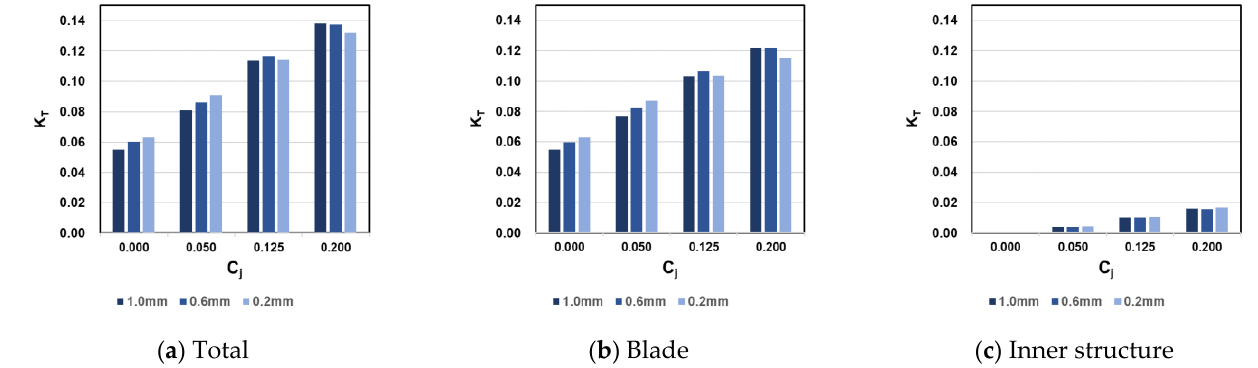
Figure 14. K T according to C j for each part of the propeller with each slit height ( J A = 0.4). When the jet is not injected, the highest thrust is displayed at h S = 0.2 mm, which is a phenomenon manifested by the hydrofoil shape. Looking at Figure 12, there is a part where the hydrofoil is cut by the slit in the with jet section. The lower the slit height, the more the existing hydrofoil shape will be maintained, so most will appear when the jet is not injected in the lowest slit height. However, although the thrust increase appears differently depending on the slit height, most thrust appears when C j = 0.2 and h S = 1.0 mm. Figure 15 shows the thrust PUA and velocity distribution of the propeller surface by C j . Only the negative tangential velocity contour is shown for convenience to see the jet distribution. The jet injection distribution is different according to the slit height. When h S = 0.2 mm, it can be confirmed that the jet injected from the slit is generated in a narrow ad fast flow, and the jet rides to the end of the blade, where it does not separate due to the Coanda effect. In addition, the small slit area increases the pressure of the inner structure, resulting in a pattern in which jets are injected from the entire slit. In contrast, when the height of the slit is increased, the area of the slit is increased, and the jet injection velocity is reduced. As a result, the Coanda effect causes the jet to flow on the blade, but it is relatively separated and disappears quickly. The jet injection pattern is also concentrated at high r/R due to the centrifugal force caused by the rotation of the propeller.